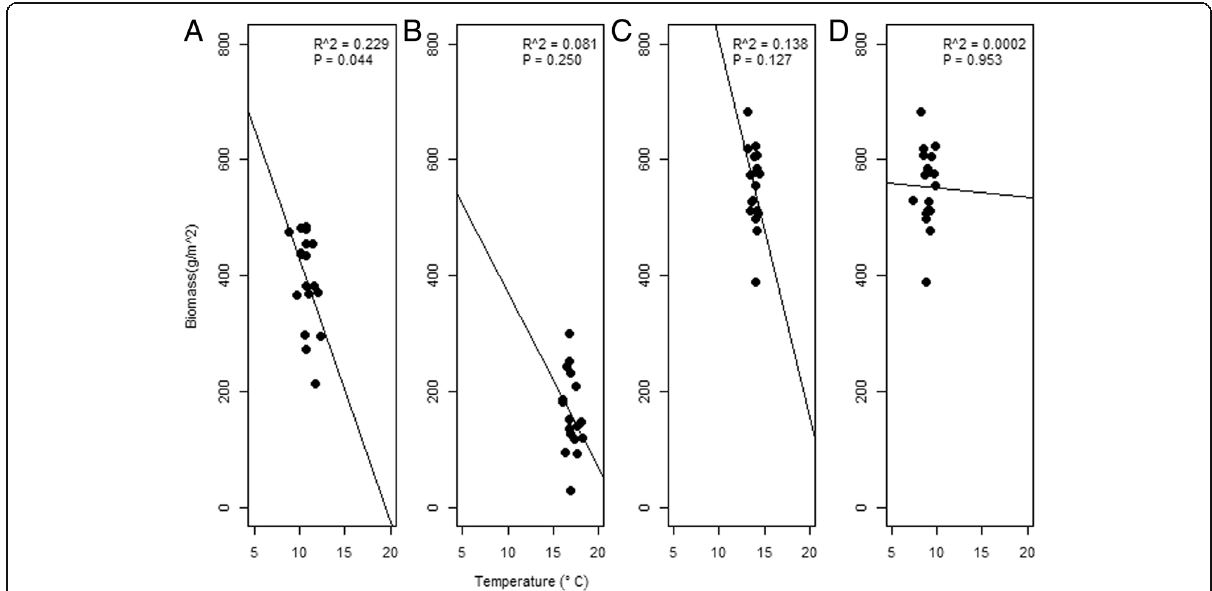
Fig. 4 Response of aboveground biomass productivity to temperature variability for the study period 1997 – 2015, excluding the extreme event 2003. Relationships of aboveground biomass in June with growing season (March – June) temperature ( a ), biomass in September with